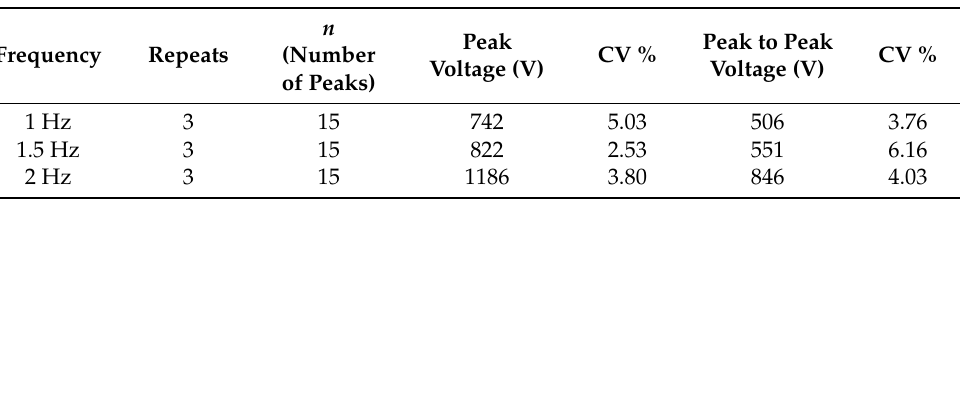
Table 1. Effect of different frequency on the electrostatic charge